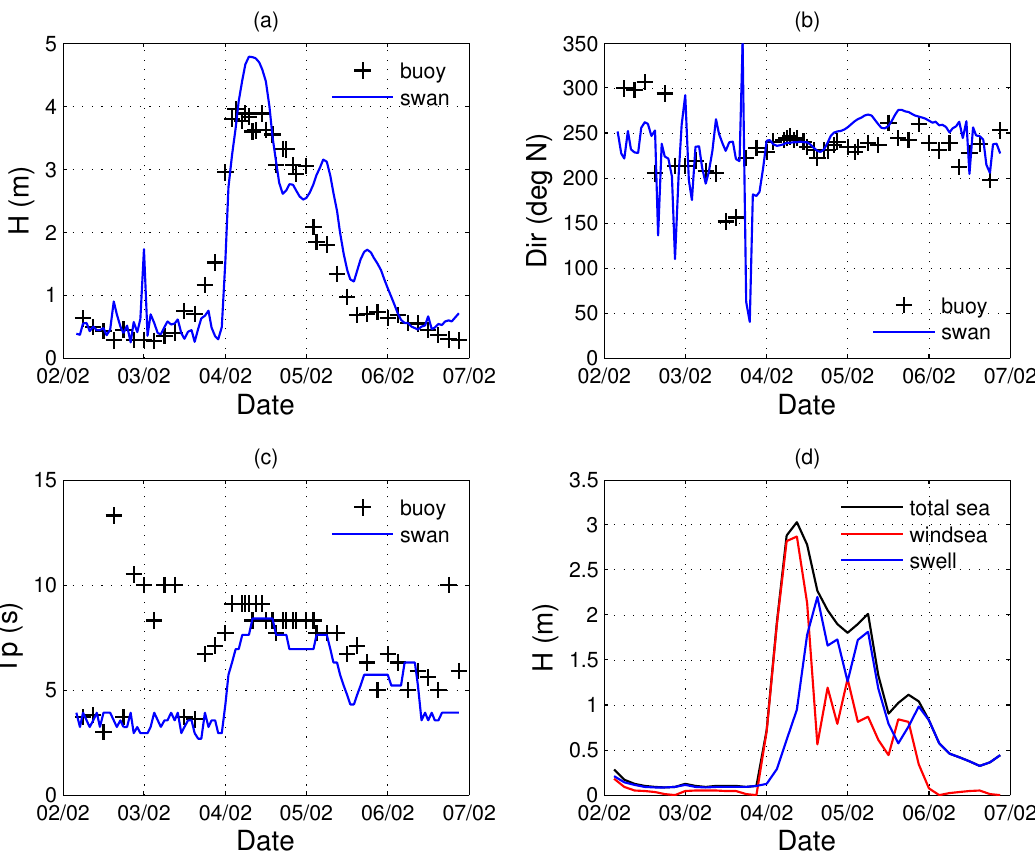
Fig. 11. Civitavecchia, 2–7 February 2003 storm: (a) comparison of SWAN vs. buoy H s , (b) comparison of SWAN vs. buoy Dir, (c) com- parison of SWAN vs. buoy T p , (d) WAM series of wind sea, swell and total H s out of the regional grid.